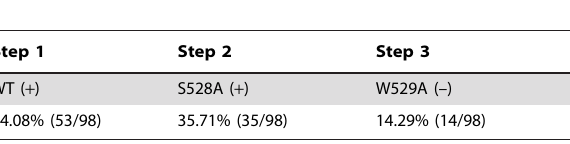
Table 3. Presence of ‘‘1H8-like’’ antibody in patients with chronic HCV